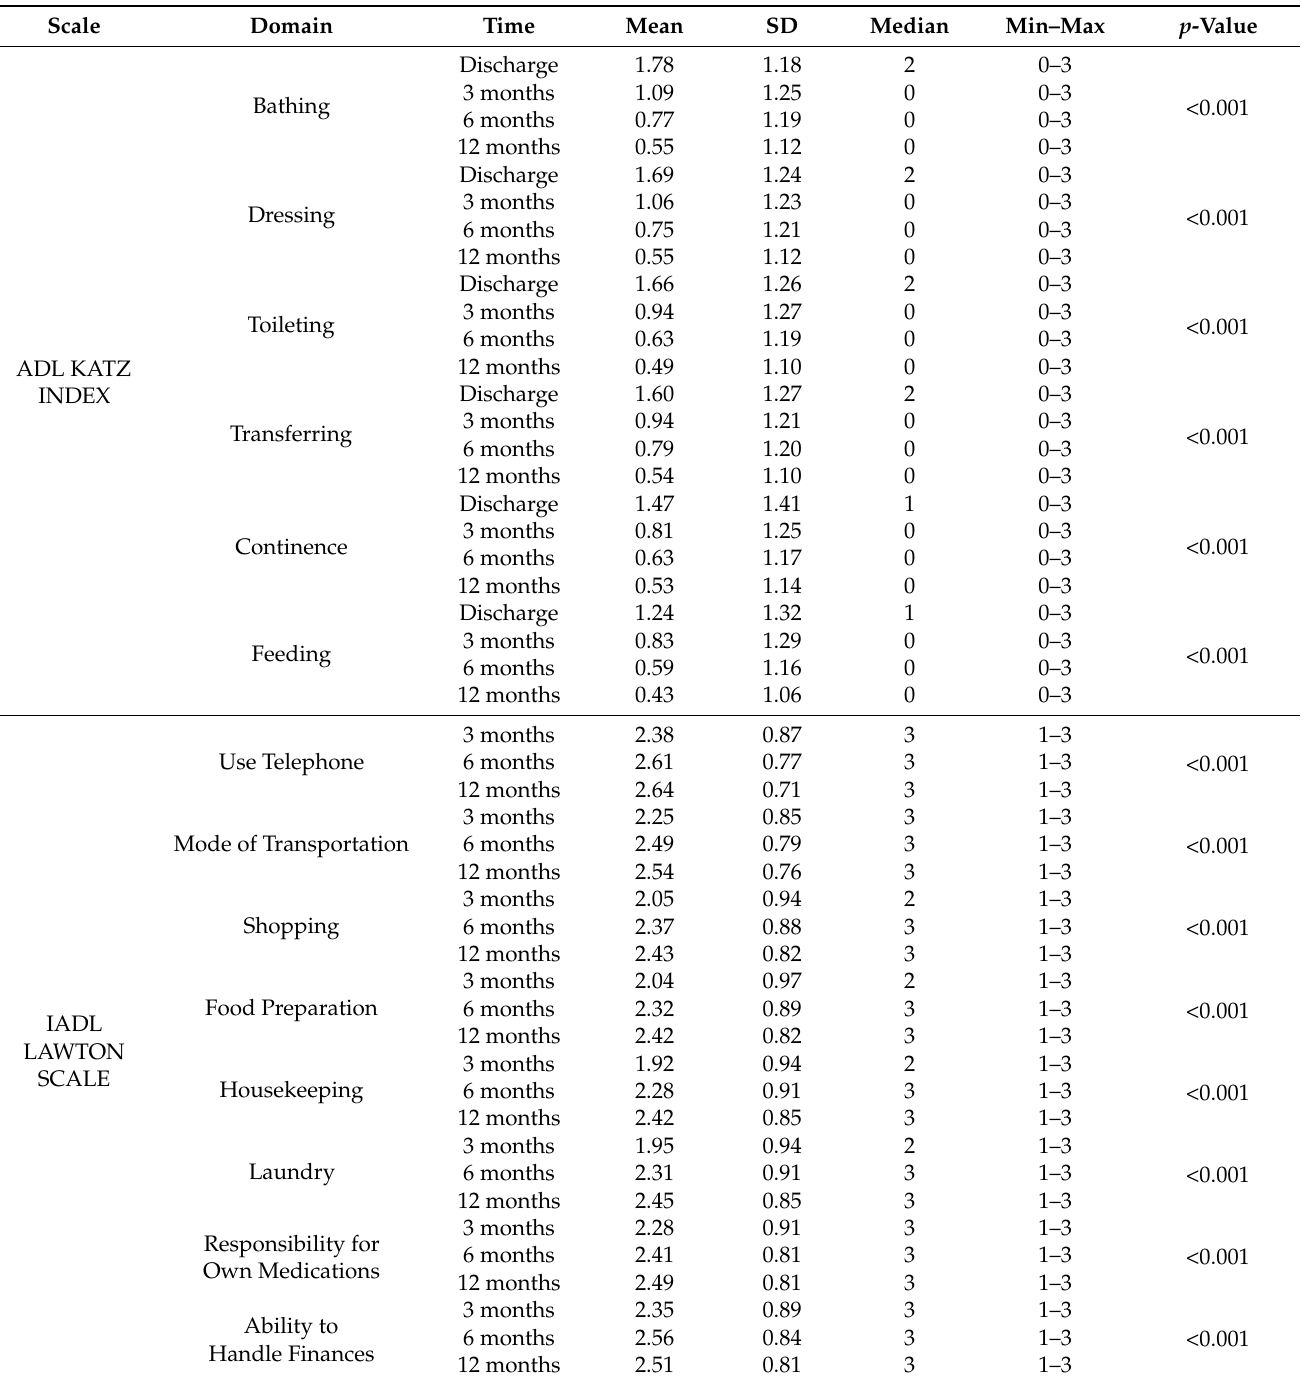
Table 3. Comparison of ADL and IADL domains between hospital discharge and twelve months for victims of severe TBI with focal